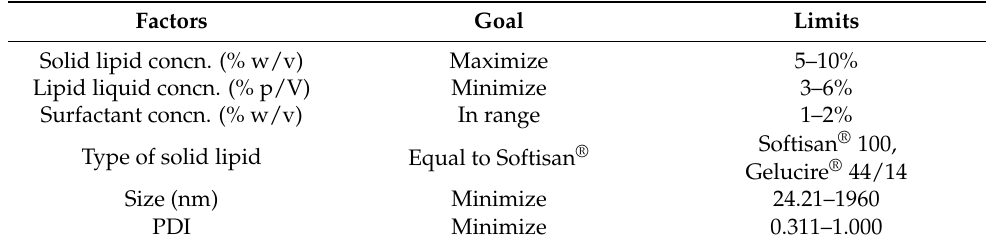
Table 3. NLC optimization process.